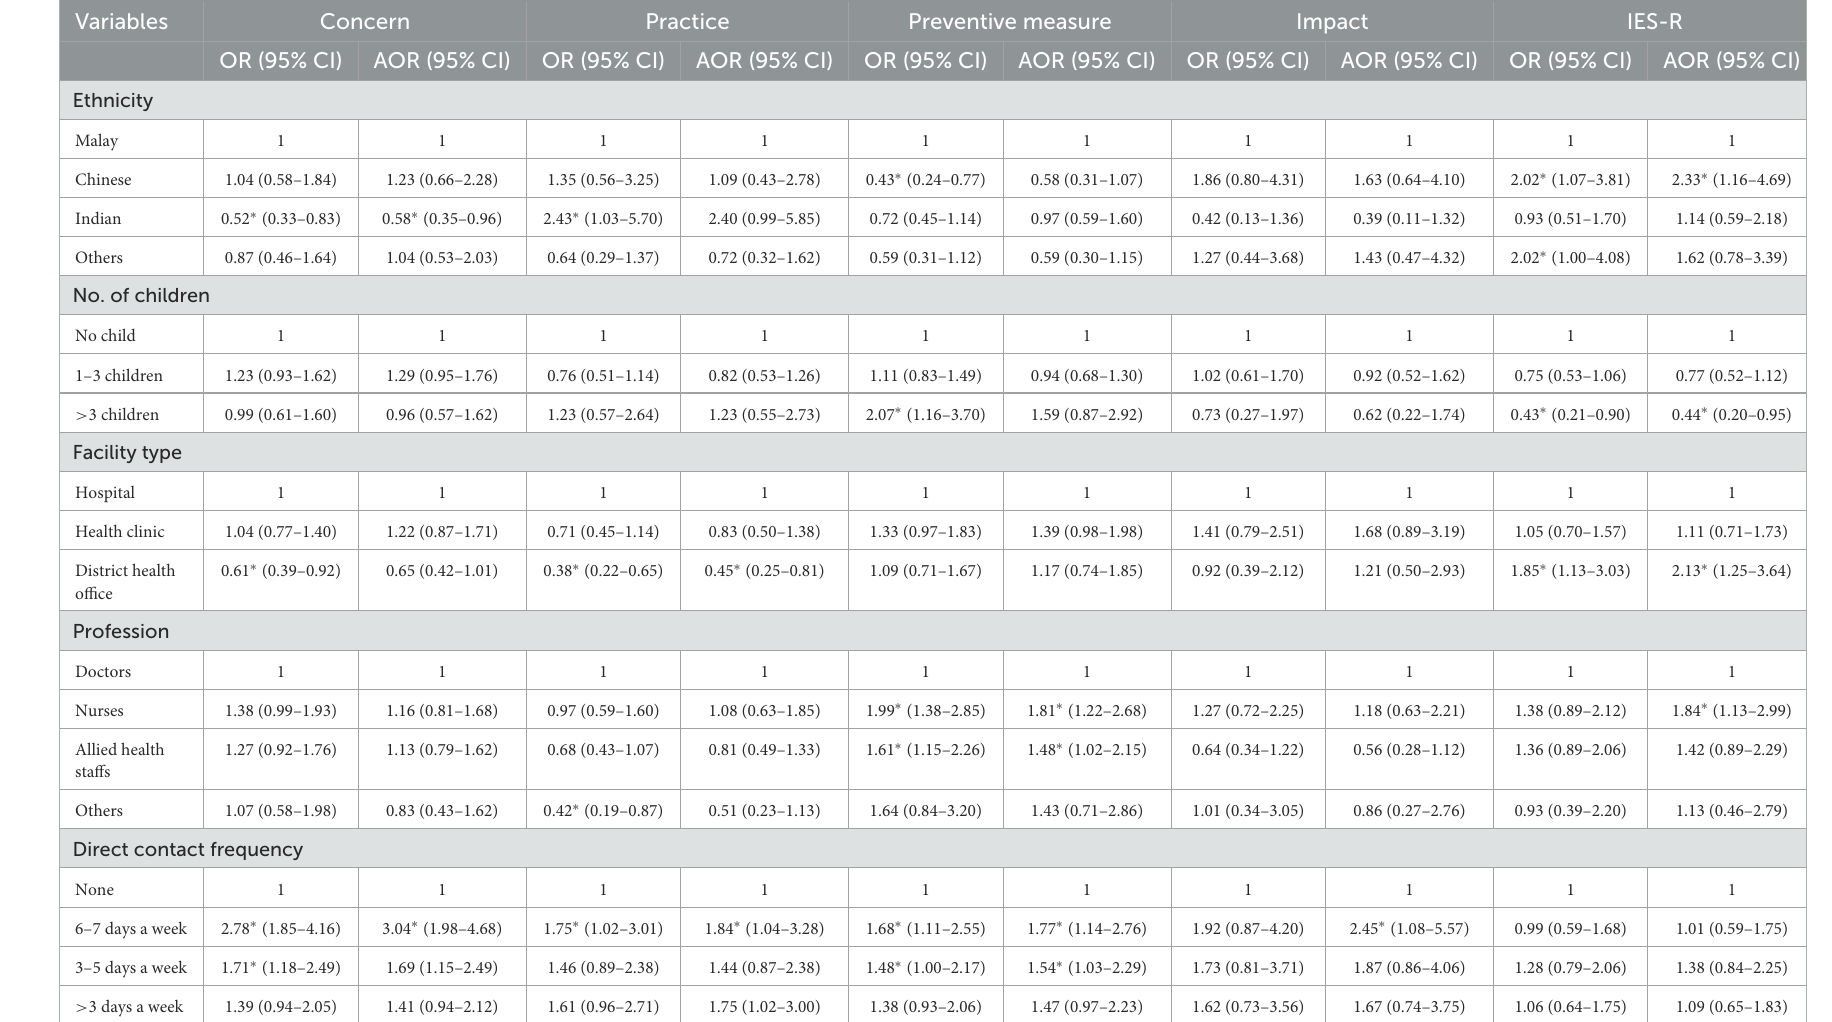
TABLE 2 Sociodemographic and occupational factors associated with concern, practice, preventive measure, impact, and IES-R domain.